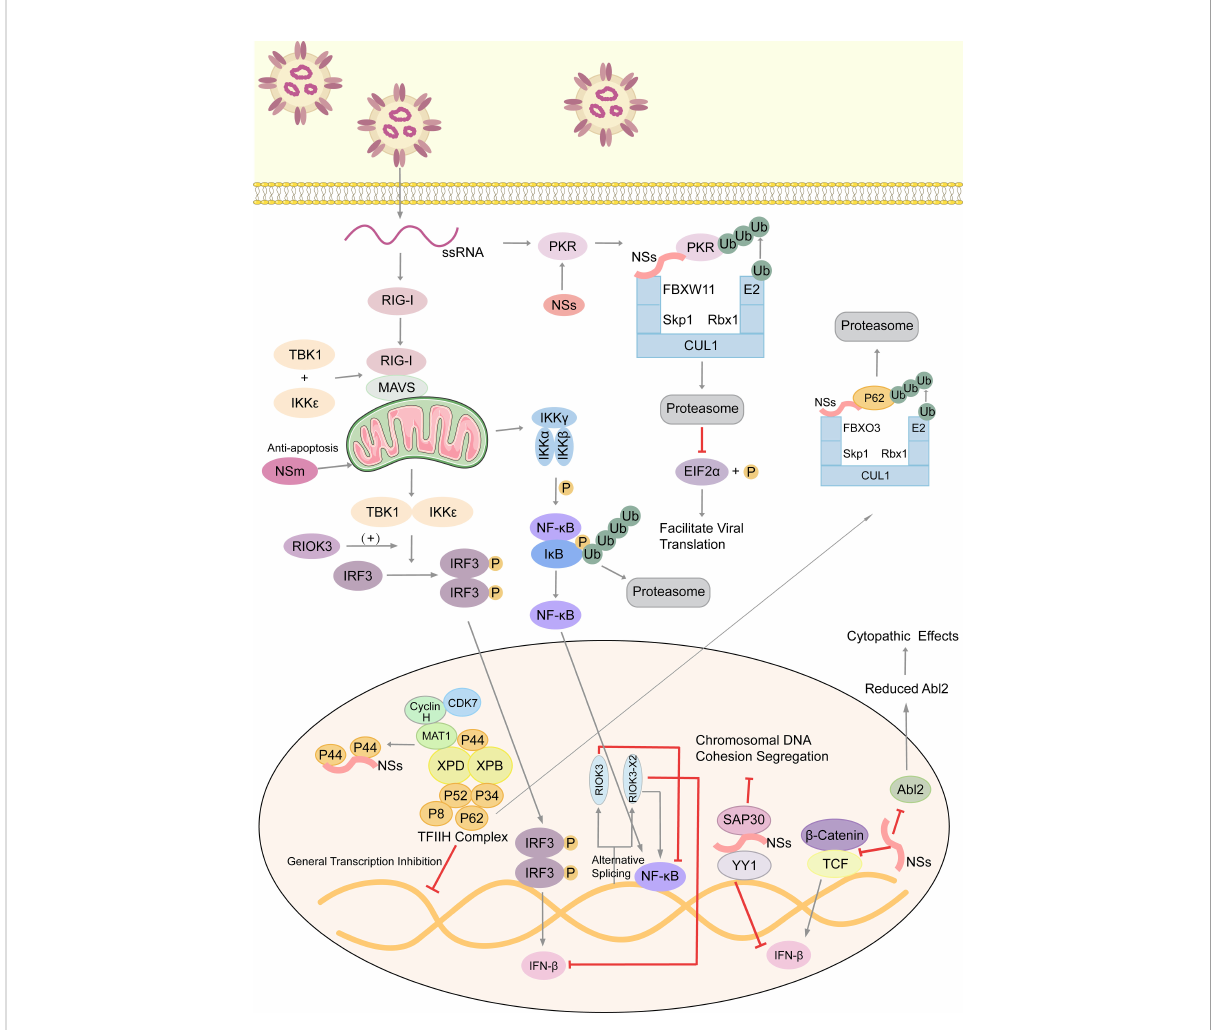
FIGURE 2 Arm race between RVFV and host, with emphasis on immune evasion by RVFV. RVFV ssRNA is recognized by cytosolic RIG-I. RIG-I associates with mitochondrial MAVS to activate multiple innate immune pathways. The kinase RIOK3 facilitates IFN expression and inhibits the in fl ammatory response pathway mediated by NF- k B, while the alternative splicing isoform RIOK3 X2 antagonizes these effects. RVFV infection also stimulates the Wnt pathway to produce IFN b , but the NSs protein inhibits this process. NSs conduct the immune escape from several aspects. Those include inhibiting the aggregation of TFIIH complex to extensively inhibit host transcription, degrading kinase PKR to decrease eIF2 a phosphorylation and promote the translation of viral proteins, and forming SAP30-NSs-YY1 co-repressor complex at the IFN promoter to block its transcription. Moreover, NSs affect the formation of cytoskeleton via suppressing Abl2 expression, which changes cell morphology and movement. Also, NSs could damage the host chromosomal DNA and disrupt mitosis. NSm, however, plays an anti-apoptotic role in mitochondria. ssRNA, single-stranded RNA; RIG-I, retinoic acid-inducible gene I; MAVS, mitochondrial antiviral signaling protein; TBK1, TANK- binding kinase 1; IKK, inhibitor of k B kinase; I k B, inhibitor of NF- k B; IRF3, interferon regulatory factor 3; TCF, T-cell factor; RIOK3, RIO Kinase 3; TFIIH, transcription factor IIH; CUL1, cullin 1; FBXO3, F-box protein 3; Skp1, S-phase kinase associated protein 1; FBXW11, F-box and WD repeat domain containing 11; Rbx-1, ring-box 1; PKR, protein kinase R; eIF2 a , eukaryotic initiation factor 2 a ; SAP30, Sin3A associated protein 30; YY1, transcription factor Yin Yang 1; Abl2, Abelson murine leukemia viral oncogene 2; P, phosphate group; Ub,